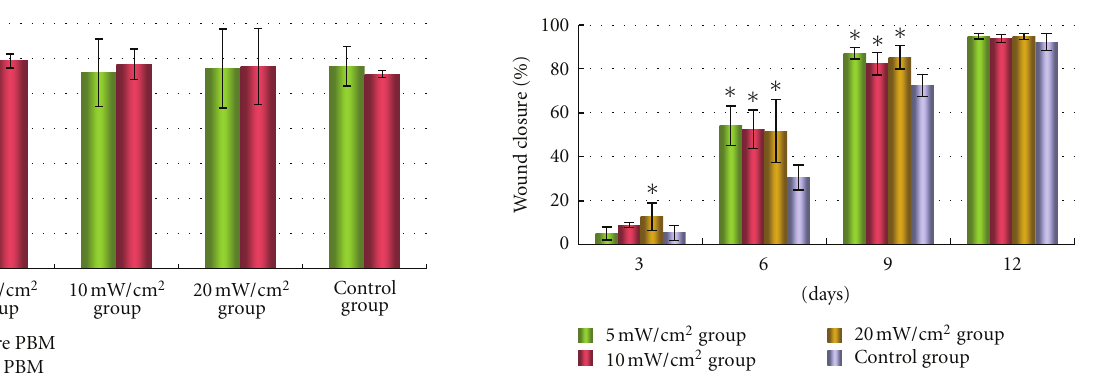
Figure 1: Blood glucose levels of all groups throughout the exper- iment.